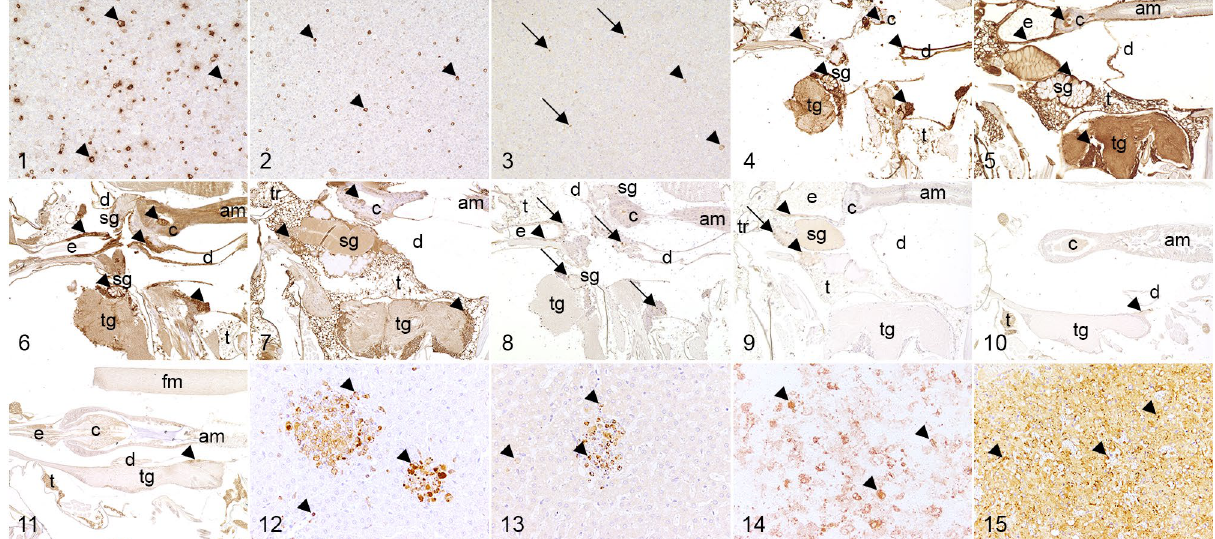
Figure 1–15. Comparison of epitope expression in mammal and insect specimens with intracytoplasmic (arrowheads) or intranuclear (arrows), granular signals for Rift Valley fever virus (RVFV). Figure 1–3: Immunoreactivity in RVFV-infected C6/36 cell pellet for the antibodies Np9 (1), Gc9A9 (2) and NSs5F12 (3). Figure 4–9: Immunohistochemical demonstration of the antibodies Np9 (4-5), Gc9A9 (6-7) and NSs5F12 (8-9) in RVFV-infected Culex pipiens quinquefasciatus (Fig. 4, 6, 8) and Aedes aegypti (Fig. 5, 7, 9). Figure 10: Immunoreactivity in RVFV-infected Drosophila melanogaster yellow-white for the antibody Np9. Figure 11: Immunohistochemical demonstration of the antibody Gc9A9 in Drosophila melanogaster cinnabar brown . Figure 12–13: Immunoreactivity in RVFV-infected ovine liver tissue for the antibodies Np9 (12) and Gc9A9 (13). Figure 14–15: Immunohistochemical demonstration of the antibodies S24Np (14) and Gc9A9 (15) in RVFV-infected C57Bl/6-IFNAR tmAgt murine liver tissue. Note the signal within multifocal lesions in ovine liver samples (Fig. 12–13). In contrast, C57Bl/6-IFNAR tmAgt mice exhibited a diffuse expression of Rift Valley fever antigen (Figure 14–15). am anterior midgut, c cardia, d diverticulum, e esophagus, fm flight muscle, sg salivary gland, tg thoracic ganglia, t trophocytes.